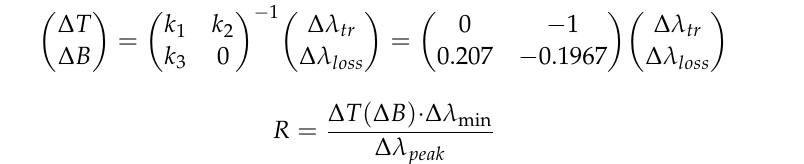
Figure 8. The loss spectra ( a ) and transmission spectra ( b ) under different magnetic fields for the optimized sensor, T = 10 ◦ optimized sensor, T = 10 °C.